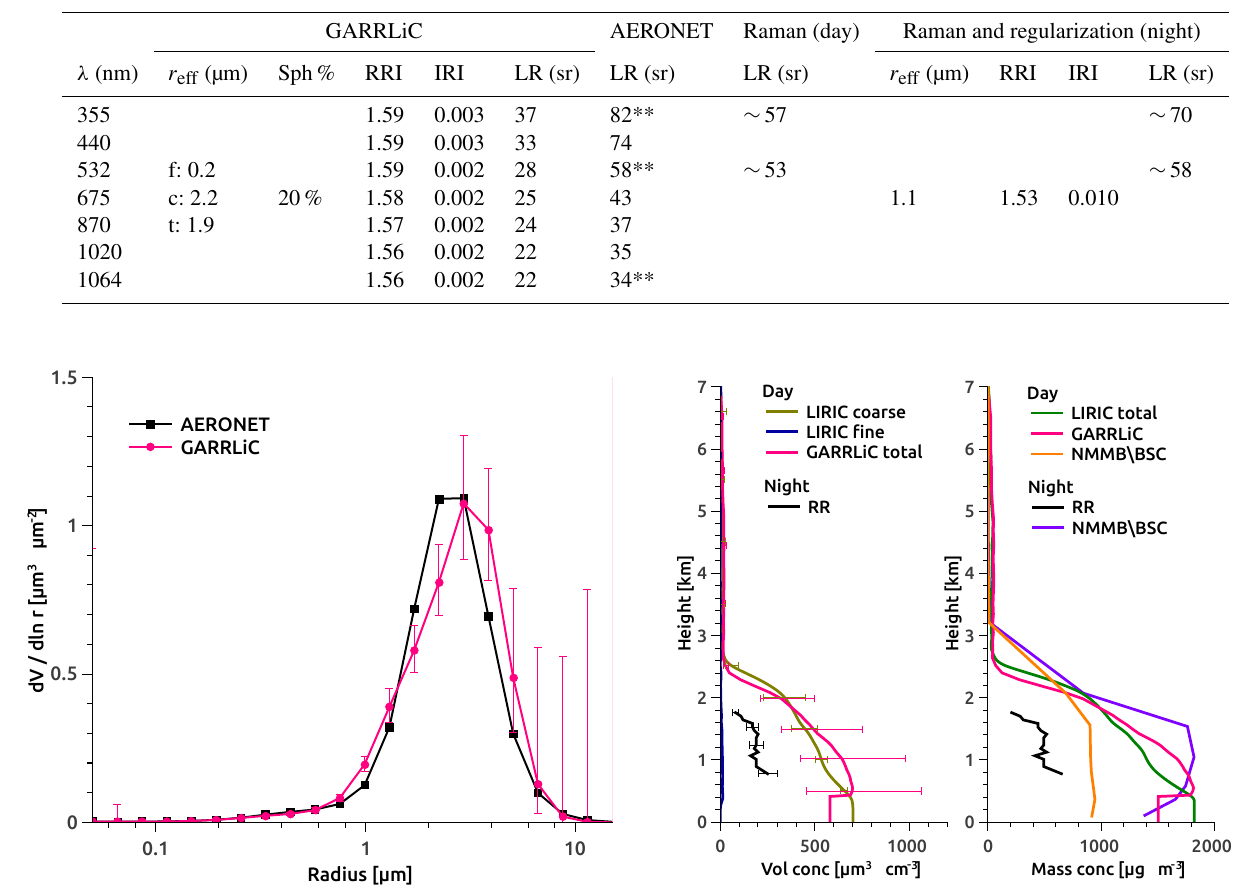
Table 2. Aerosol properties during the dust event over the Dakar site on 29 March 2015. Here and further, the LR values marked by ** were retrieved by using the LIRIC algorithm. Only the values given for all the wavelengths refer to the column-integrated property. Day: AOD